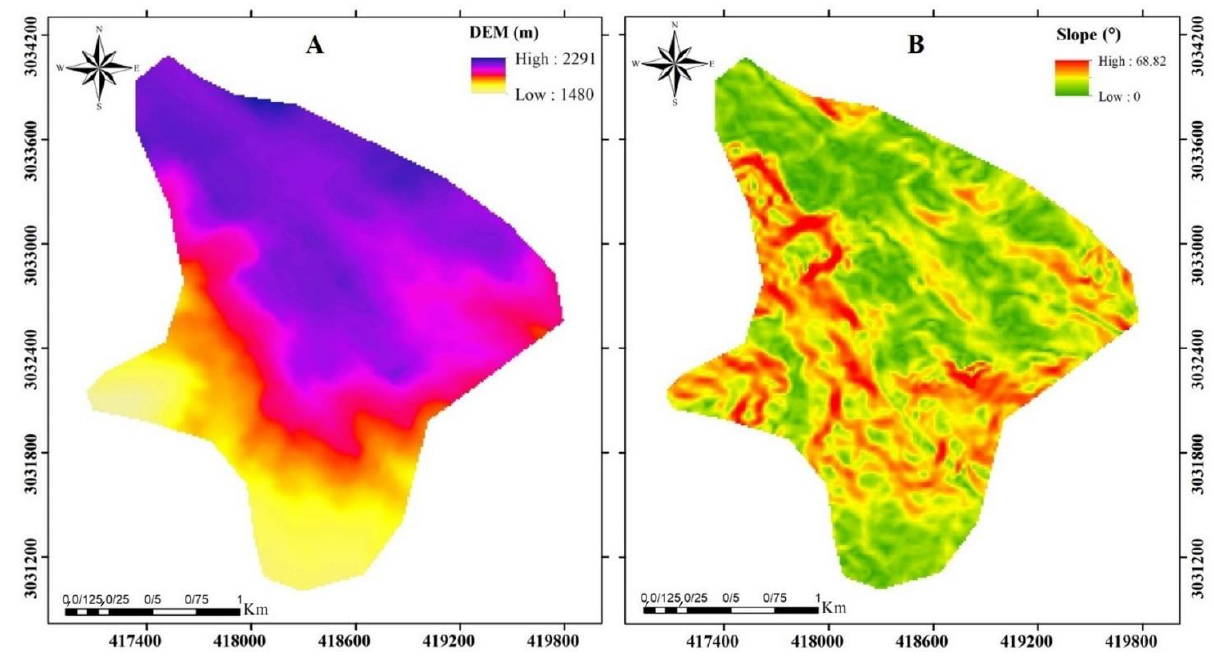
Figure 1. Habitat basin and DEM ( A ), and slope degree ( B ).